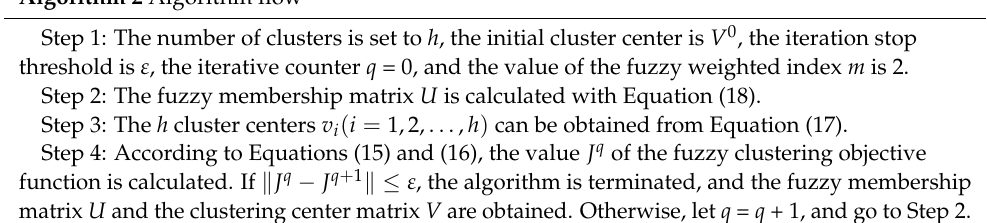
Algorithm 2 Algorithm